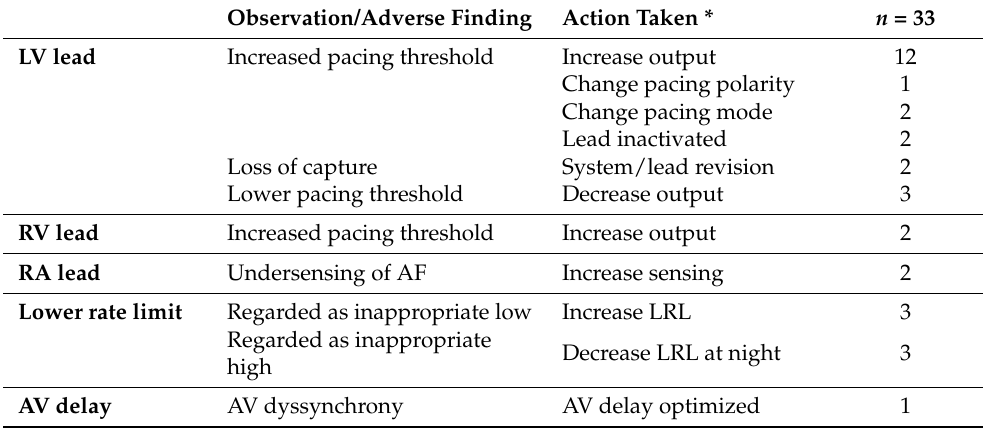
Table 9. Post-operative CRT interrogation. Observations requiring intervention in 29